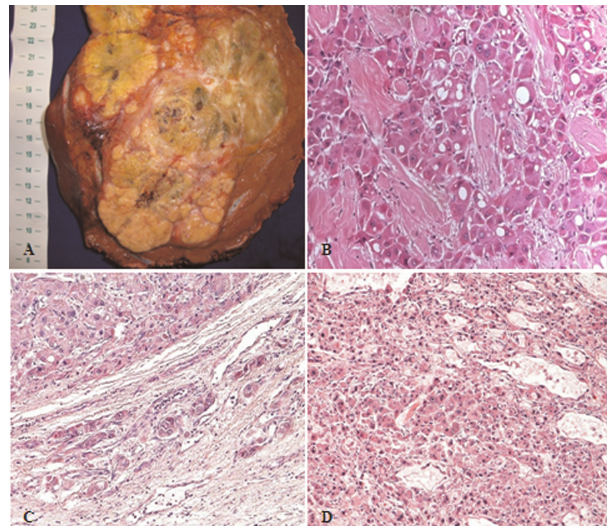
Figure 2 - Pathological aspects of fibrolamellar hepatocellular carcinoma. (A) Surgical specimen of a large, well-circumscribed, yellow, heterogeneous mass with areas of necrosis and a central scar. (B) Histopathology of ‘‘pure fibrolamellar hepatocellular carcinoma’’: large tumor cells with deeply eosinophilic cyto- plasm, round, central macronucleoli, and abundant fibrous stroma arranged in thin parallel lamellae around the tumor cells. (C): Fibrolamellar hepatocellular carcinoma showing micro- vascular invasion; (D): ‘‘Mixed fibrolamellar hepatocellular carcinoma’’: classical fibrolamellar hepatocellular carcinoma cells are found intermingled with neoplastic cells with features of conventional